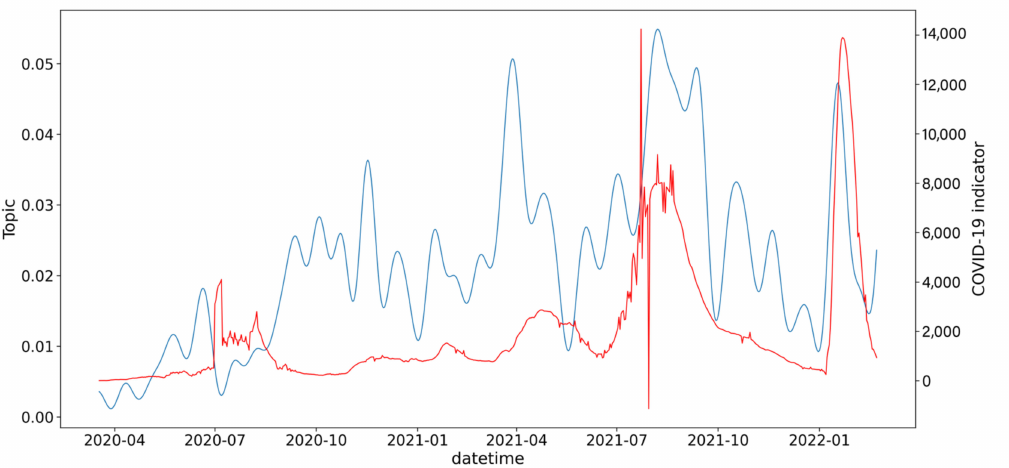
Figure 5. The red line is the dynamics of the number of new cases smoothed COVID-19, and the blue line is the dynamics of publication activity on the topic “Incidence, School, Child, Growth, Epidemiology”.